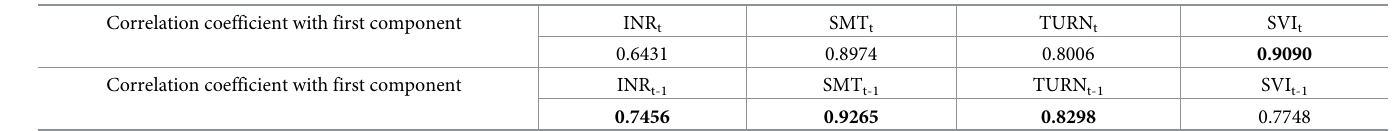
Table 4. Correlation coefficients between proxy variables and the first component.